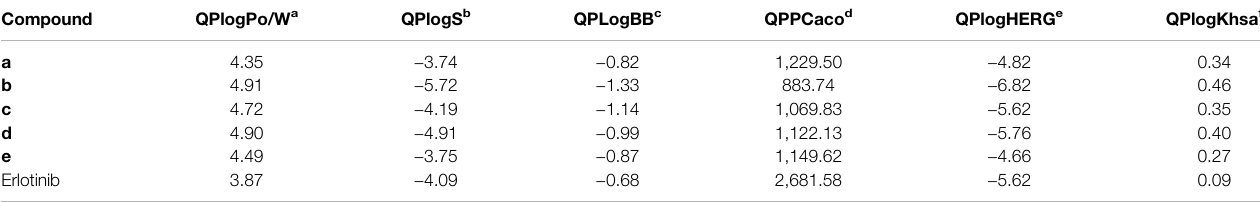
TABLE 5 | Predicted ADME-related properties of the compounds by Qikprop. Compound QPlogPo/W a QPlogS